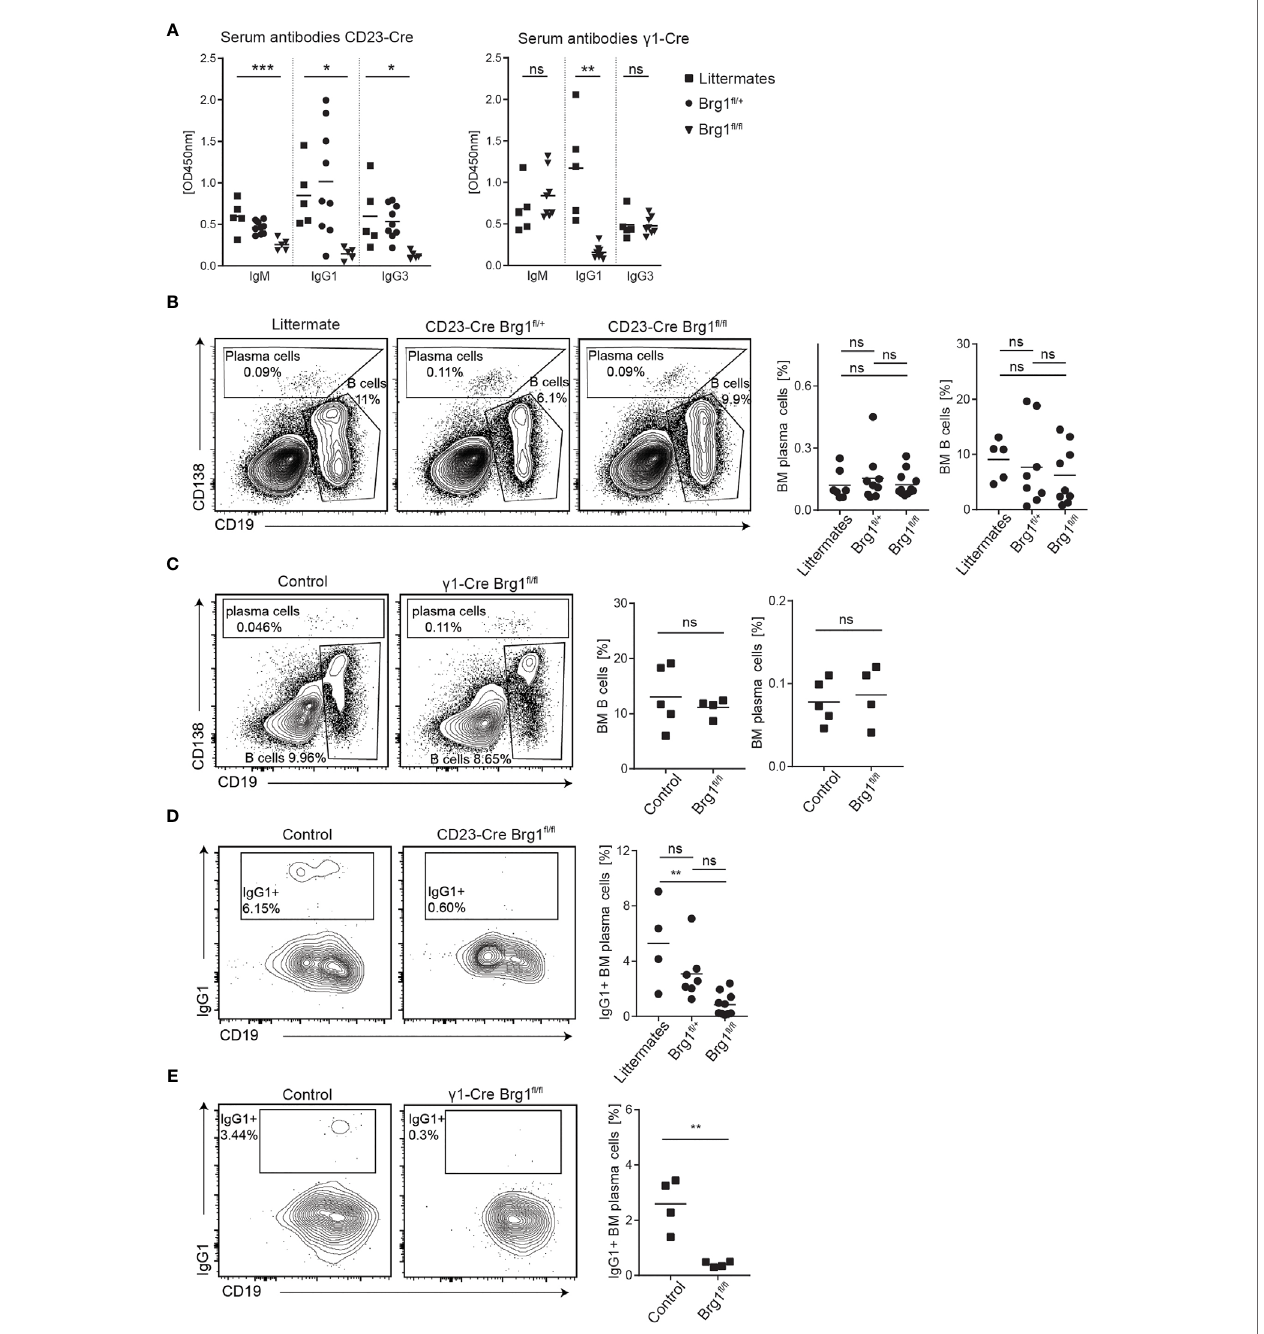
FIGURE 3 | Brg1-de fi ciency in B cells causes a reduction in serum antibodies and class-switched plasma cells. (A) ELISA for IgM, IgG1, and IgG3 in the serum of unimmunized CD23-Cre and g 1-Cre littermate, Brg1 fl /+ and Brg1 fl / fl mice. One-way ANOVA with post hoc Tukey ’ s multiple comparisons test. Following p values are represented by the asterisks ’ : p<0.05 = *; p<0.01 = **; p<0.001 = ***; p>0.05 = ns (not signi fi cant). (B) Analysis of BM B cells and CD138 + cells in CD23-Cre mice by fl ow cytometry. (C) Analysis of BM B cells and CD138 + cells in g 1-Cre mice by fl ow cytometry. (D) Assessment of IgG1-class-switched BM CD138 + cells in CD23-Cre mice using intracellular staining. (E) Assessment of IgG1-class-switched BM CD138 + cells in g 1-Cre mice using intracellular